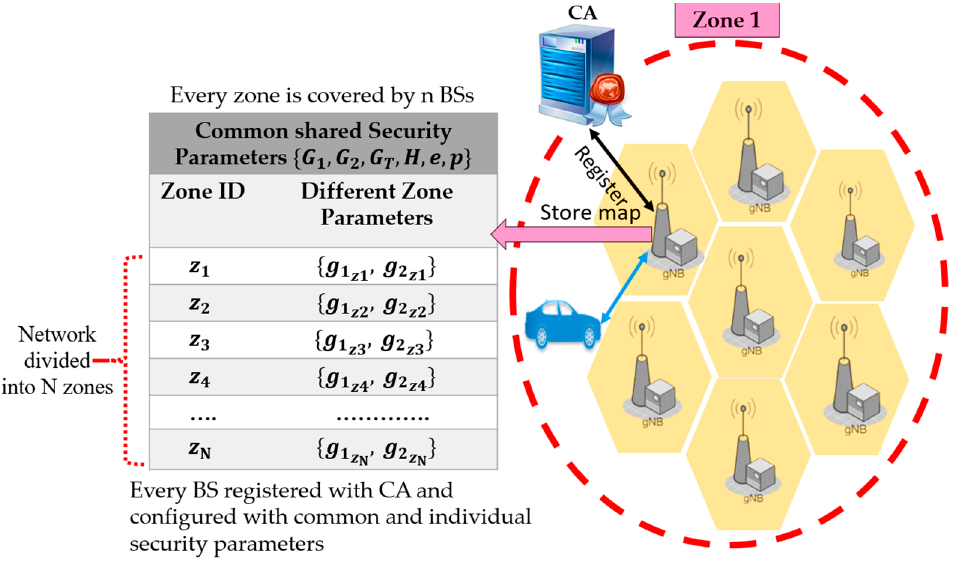
Figure 3. BSs registration with CA.